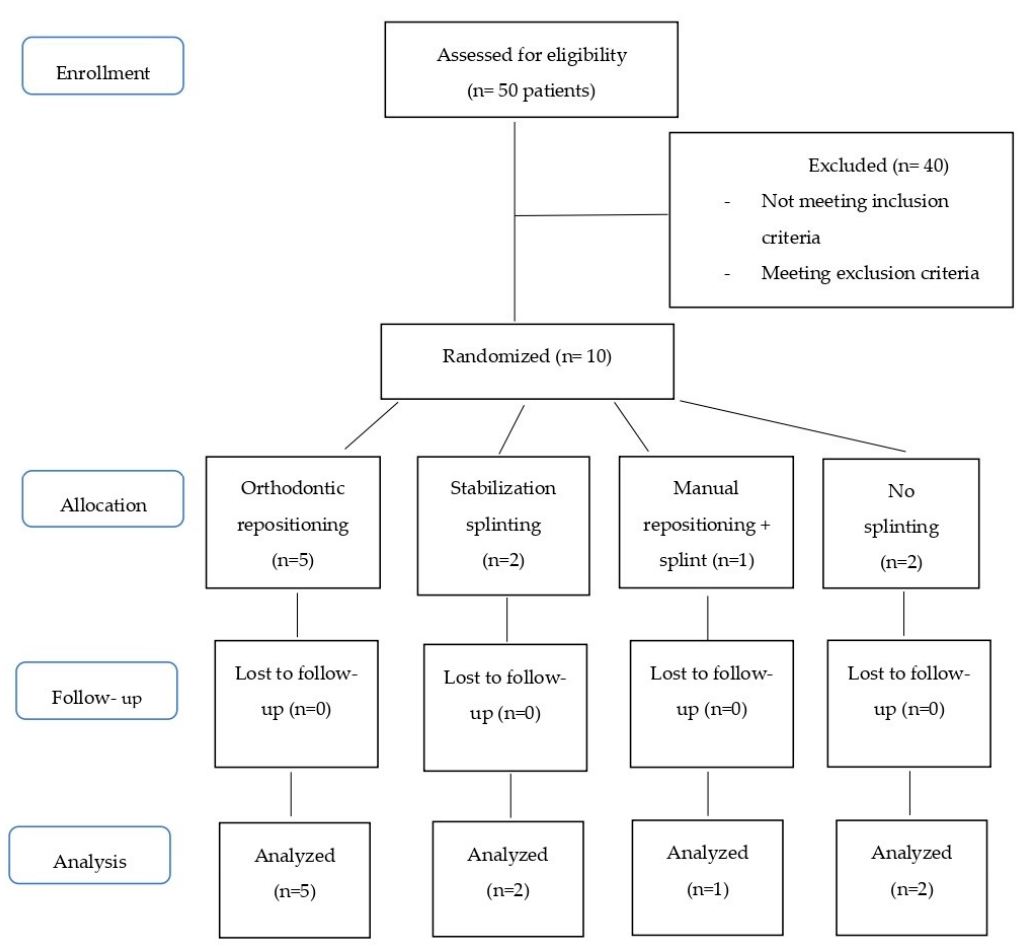
Figure 3. Flow diagram showing the phases of the study: enrollment, allocation, follow-up,